Question: Looking at the figure, what chart type is it?
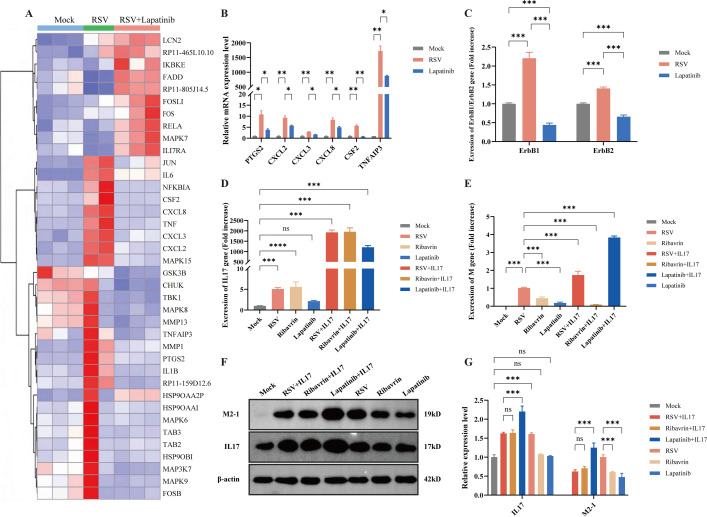
Answer: heatmap